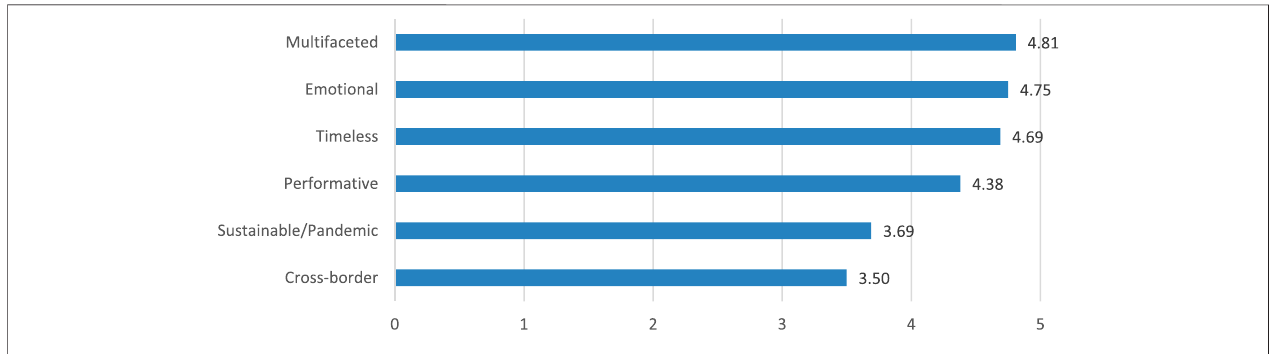
FIGURE 11 | Mean importance of the study dimensions worked on in relation to the Way of St. James.